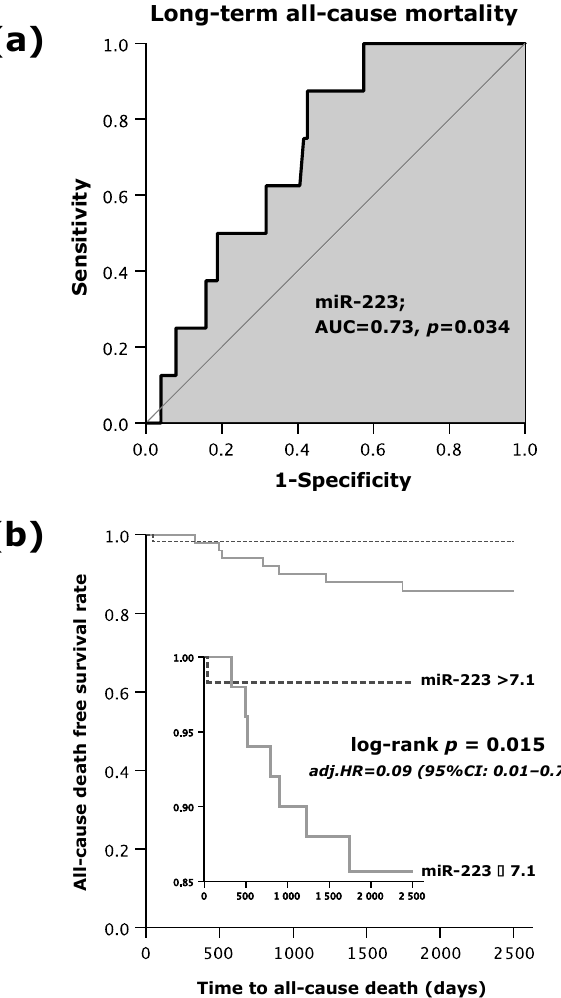
Figure 1. ( a ) Receiver operating curve (ROC) analysis for microRNA (miR)-223 to predict long-term all-cause mortality; and ( b ) Kaplan–Meier survival analysis for long-term all-cause mortality regarding high or low values of miR-223. Table 2. Statistical estimates for the prediction of long-term all-cause mortality depending on miR-223